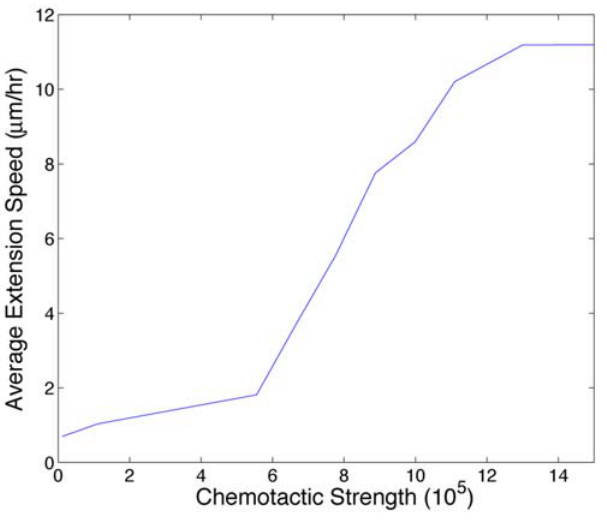
Figure 8. Plot showing the effect of varying the chemotactic sensitivity parameter, x , on average sprout extension speed at 14 hours. Below x ~ 1 : 10 4 , chemotactic cues are not strong enough relative to the energies associated with adhesion and growth to induce motility. Above x ~ 1 : 6 : 10 6 , chemotactic incentives are so strong relative to adhesion and growth that the cells